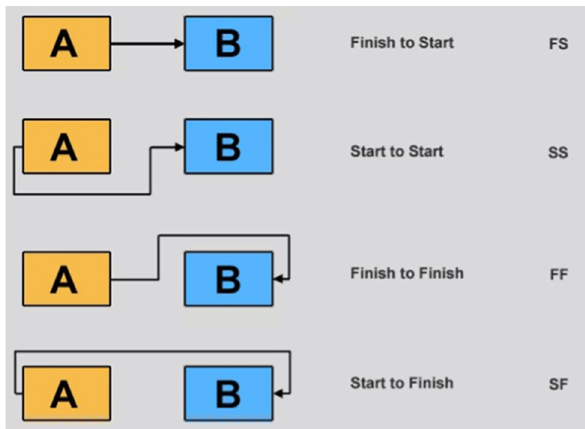
Fig. 10 Communication between activities